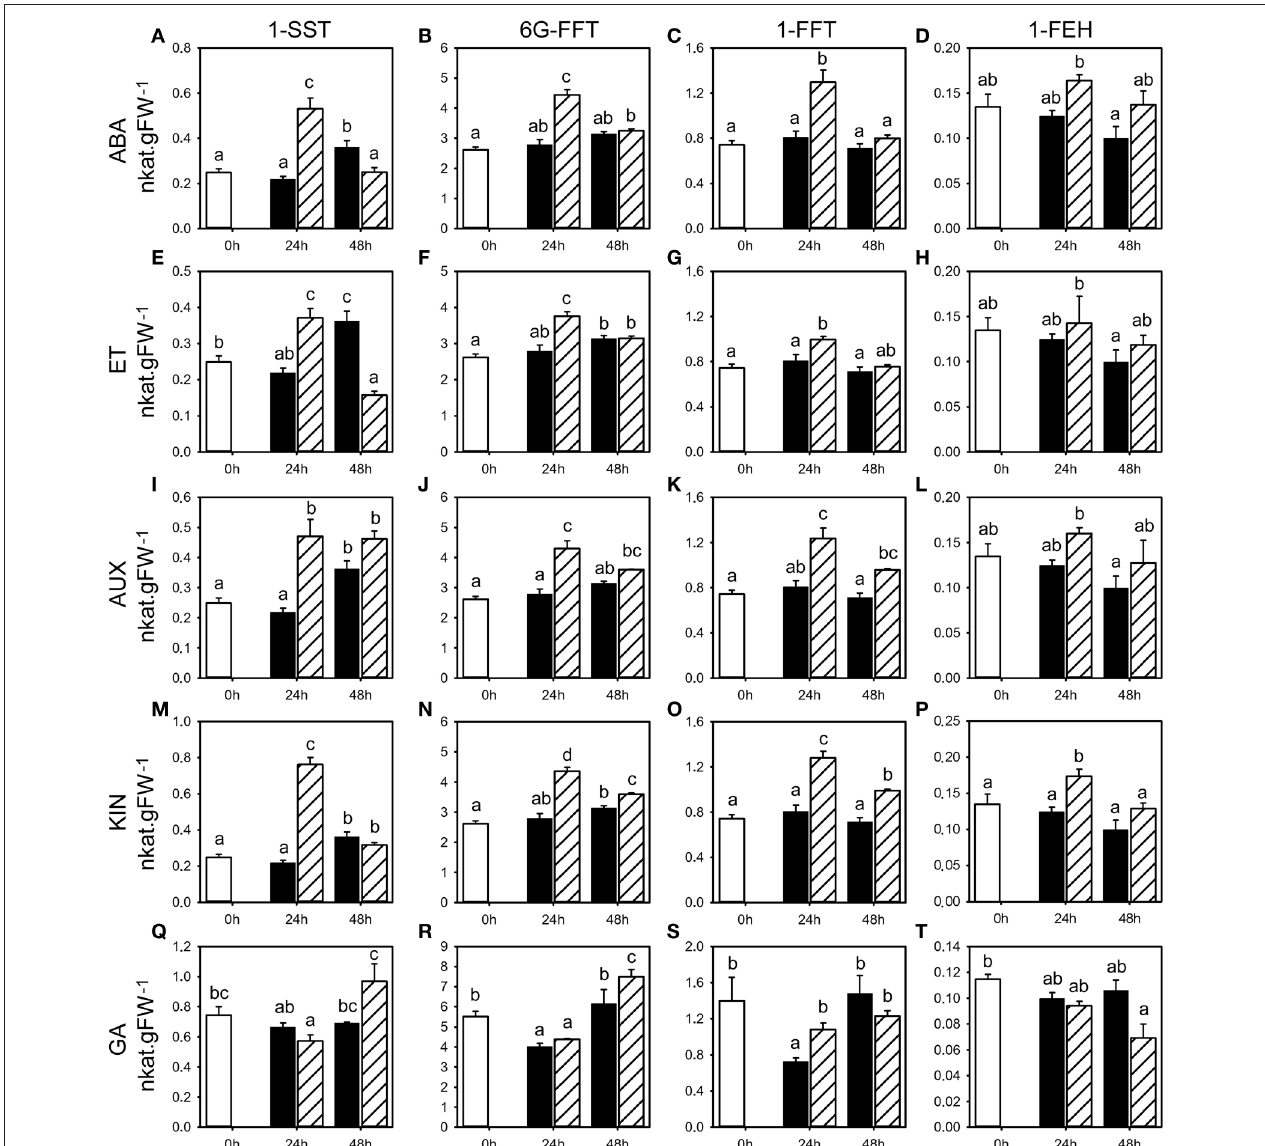
FIGURE 2 | Activities for enzymes involved in fructan metabolism following phytohormone treatments. Enzyme activities of 1-SST, 6G-FFT, 1-FFT, and 1-FEH (nkat.gFW − 1 ) in the first basal cm of stubble of 4-week old perennial ryegrass seedlings 24 or 48h post ABA (A–D) , ET (E–H) , AUX (I–L) , KIN (M–P) , or GA (Q–T) treatment, compared to untreated controls (0h). Open bars, untreated controls; closed bars, mock treatment; dashed bars, phytohormone treatment. Values represent the mean of three biological replicates ± SE. Different letters indicate statistical significance at p < 0.05 . Representative examples are shown from one of the three